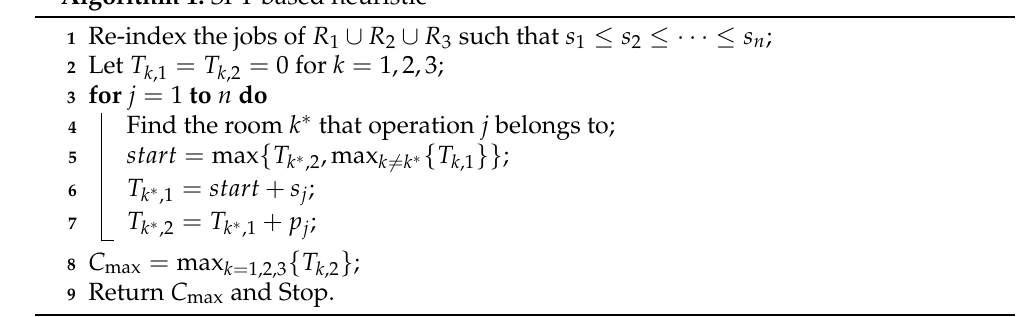
Algorithm 1: SPT-based